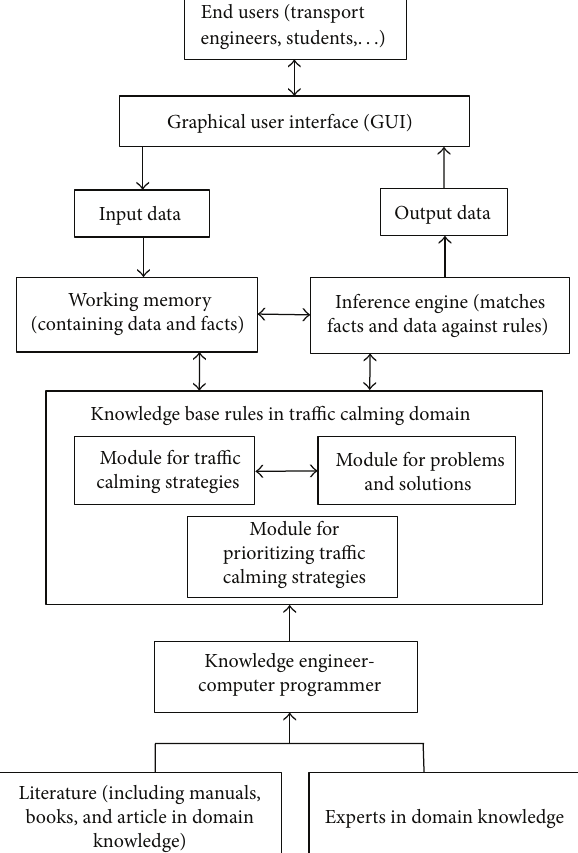
Figure 1: The structure of